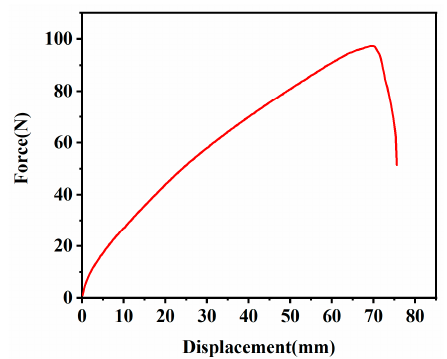
Figure5. Force-displacementcurveoftheethylenepropylenedienemonomer(EPDM)rubbercomposite Figure 5. Force-displacement curve of the ethylene propylene diene monomer (EPDM) rubber under nicked angle tear test. composite under nicked angle tear test.